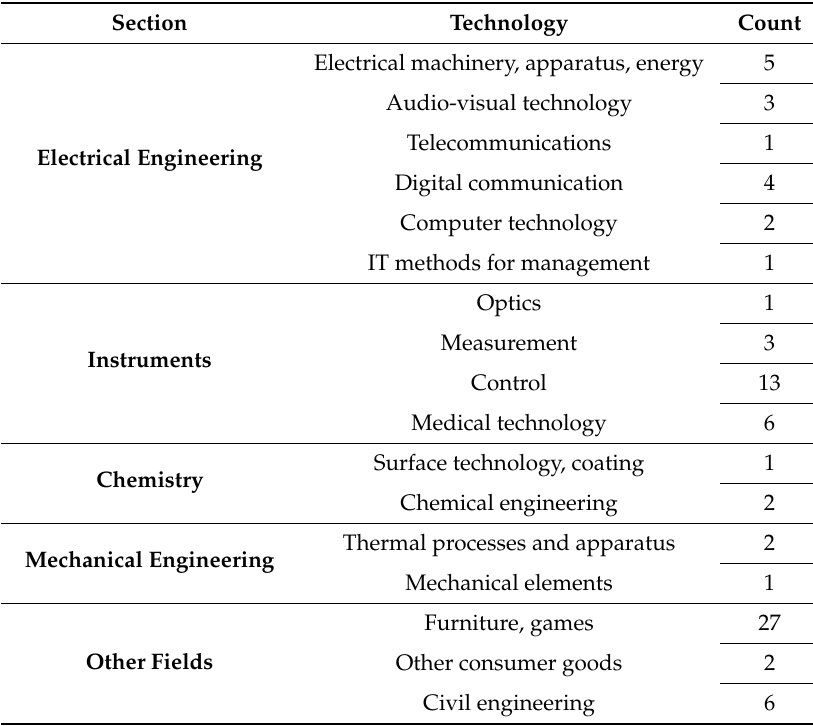
Table 5. Technological analysis based on IPC Code